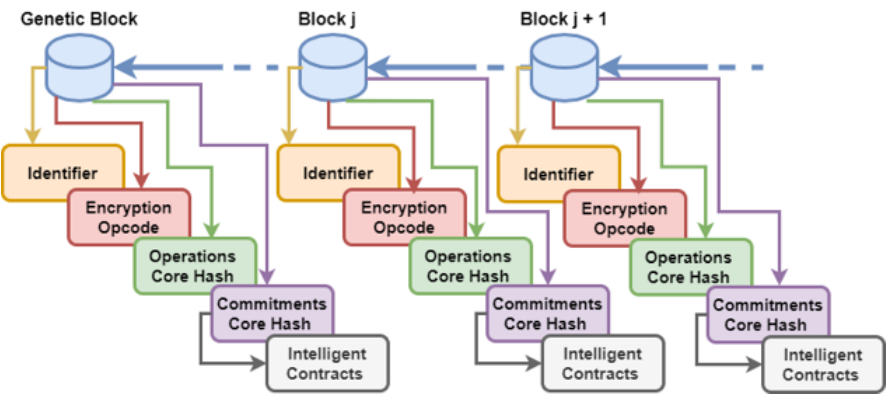
Figure 1. Functional architecture of